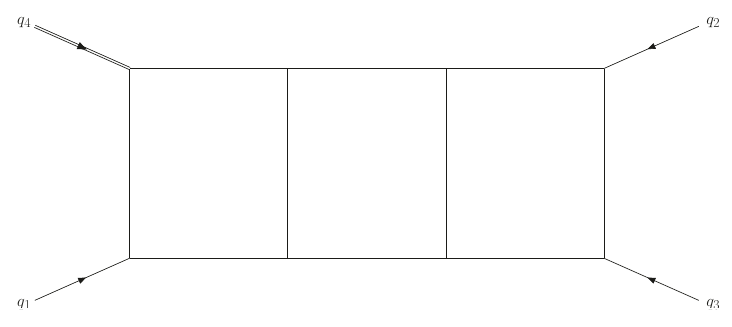
Figure 1 . The three-loop ladder-box family with one external massive